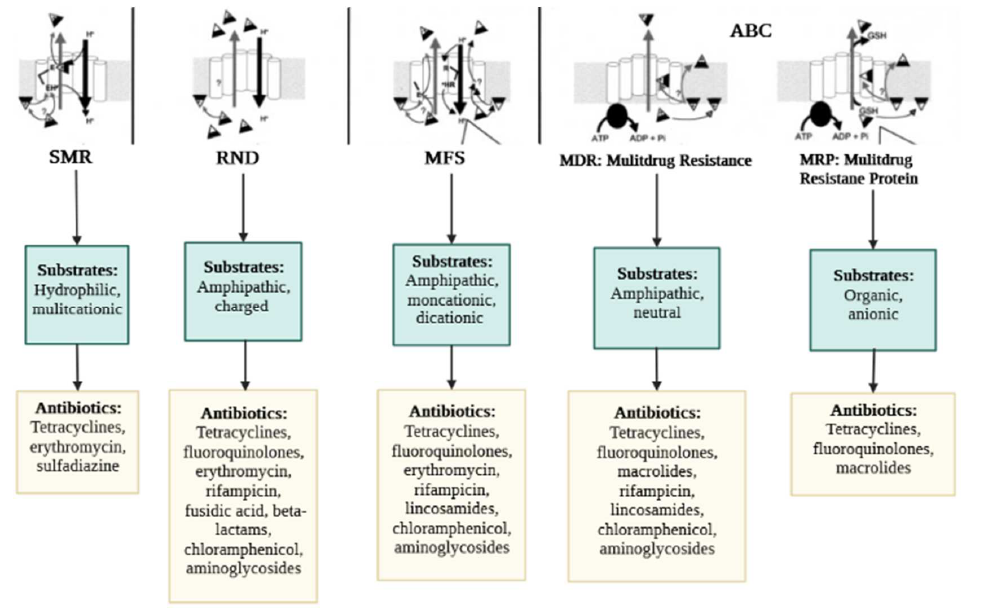
Figure 3. Mechanistic pathways and major substrates (antibiotics) of bacterial efflux pumps. Mech- anistic pathways: The proton (H + ) antiporter mechanism is used by the SMR, MFS, and RND pumps. H + is most likely transported from glutamate (E) in the “a” conserved segment of SMR and from arginine (R) in the “b” conserved portion of MFS (these domains are identified in Figure 2). The same conserved amino acid (E) for SMR pumps and a conserved amino acid residue (E or aspartate) in the “d” region for MFS proteins may suggest recognition of positively charged substrates. ATP is used as an energy source by ABC pumps. With all families of pumps, the target drug appears to be removed from the membrane instead of the cytosol. The carrier might then act as a flippase, speed- ing the flow of the chemical from the membrane's inner to the outer surface. Alternatively, the pump might act as an "aspirator," vacuuming the chemical from the membrane and transporting it to the inner region of a channel that is closed to the cytosolic section of the membrane but accessible to its outer surface. MRP transporters (ABC) also need glutathione (GSH), which can be coupled to the drug before or during extrusion. In addition, the MRP transporters (ABC) rely on glutathione (GSH), which can be coupled to the substrate either before or during the extraction process. Common sub- strates and antibiotics: Chemical classes of antibiotics for which efflux has been documented for one or more pumps in each family are grouped according to their general physicochemical properties. 2.2. Efflux Pumps Superfamilies and Their Role in Imparting Multidrug Resistance in Bacteria 2.2.1. ABC Superfamily The structure of ABC pumps differs between GPB and GNB. ABC protein in GPB is made up of one transmembrane protein. Typical examples include EfrAB, LmrA, Msr, and PatA/B. EfrAB expressed in Enterococcus faecalis [31], is a heterodimeric MDR pump, with common substrates including aminoglycosides (e.g., streptomycin, gentamicin) and phenicole (e.g., chloramphenicol). EfrAB expression is driven significantly by the sub- MIC values of such antibiotics [32]. The LmrA protein has been characterized in Lactococ- cus lactis [31]. The pump operates similarly to a homodimer, consisting of a trans-mem- brane (made up of six alpha helix) and single nucleotide-binding domains. Macrolides and lincosamides are the main compounds recognized and transported by the pump [33]. The transmembrane domain is missing in Msr detected from Streptococcus , however, un- like LmrA, two nucleotide-binding domains are found in the organization of Msr; this characteristic lends itself to macrolide resistance [34,35]. The PatA/B is another MDR pump from Streptococcus . It has been reported to target (efflux) all of the hydrophilic fluo- roquinolone class of antibiotics including ciprofloxacin and norfloxacin [36].